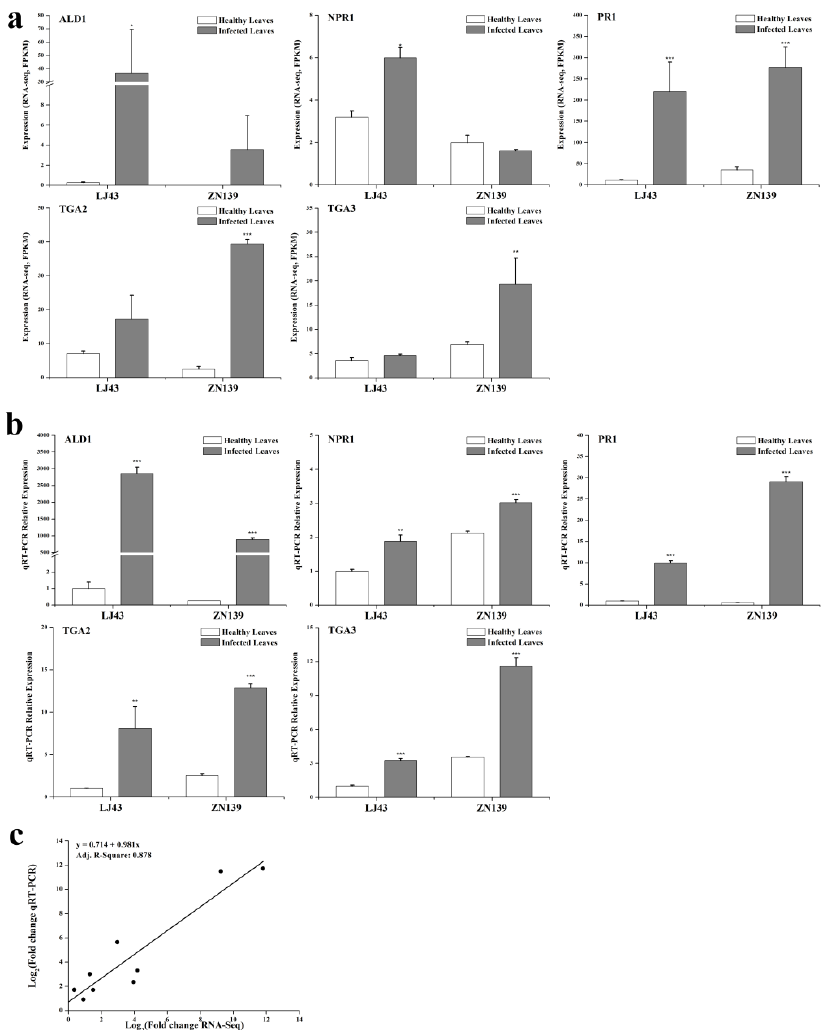
Figure 6. Quantitative reverse transcriptase polymerase chain reaction (qRT-PCR) validation of DEGs and correlation analysis of results between RNA-seq and qRT-PCR. ( a ) FPKM (expected number of Fragments Per Kilobase of transcript sequence per Millions base pairs sequenced) values present RNA-seq expression of 5 DEGs. The sequence of ALD1 could be found in unigene ID LJ62765_g1 and ZN66762_g1, as NPR1 in LJ68588_g3 and ZN72573_g8, TGA2 in LJ58444_g1 and ZN66591_g2, TGA3 in LJ61836_g1 and ZN62926_g1, PR1 in LJ62639_g1 and ZN62871_g1. All RNA-seq experiments